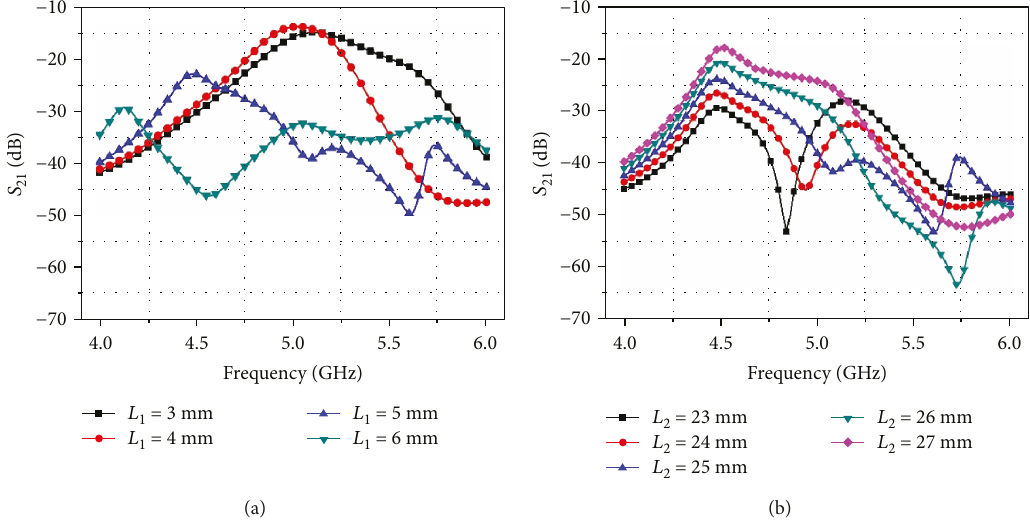
L 1 . (b) Simulated